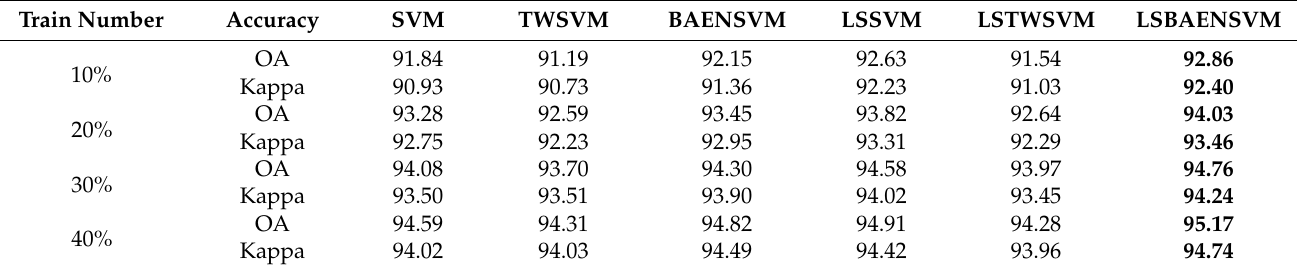
Table 4. Classification results of Kennedy Space Center hyperspectral